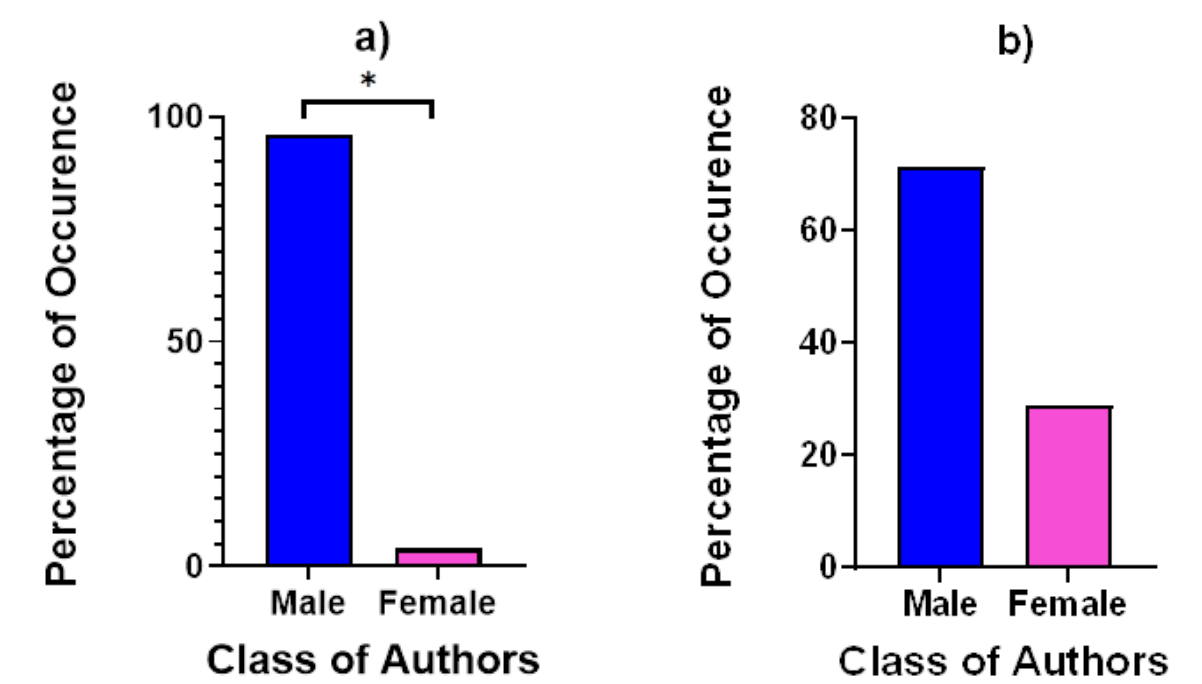
Figure 1. ( a ) Percentage of occurrence for total scent-marks associated to classes of authors. The difference between the sexes was significant. ( b ) Percentage of occurrence for investigative olfactory behaviours associated to classes of authors. A * indicates where significant differences between the sexes were found.